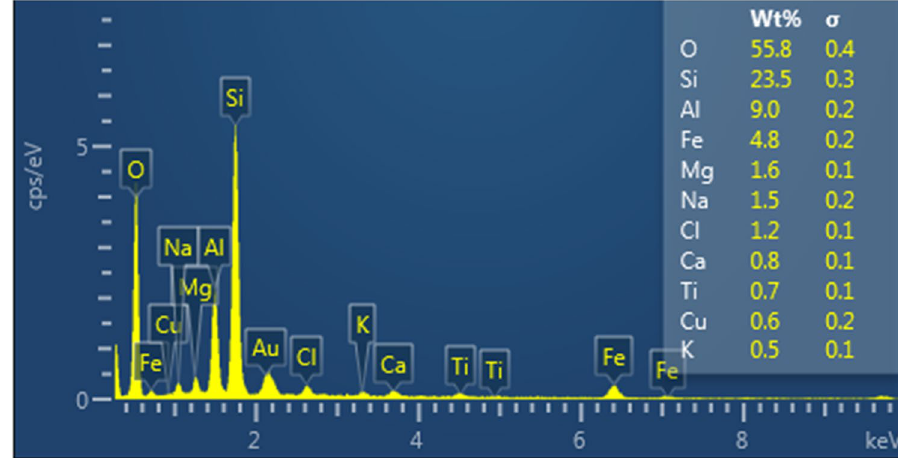
Fig. 9 Elemental composition of raw clay (before the activa-